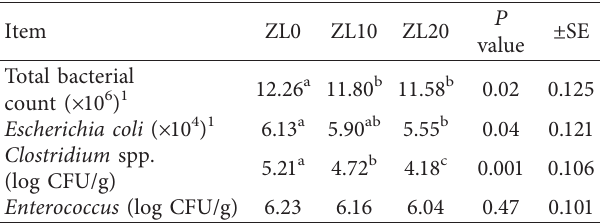
Table 3: Effects of dietary ZL supplementation on some ileal microbiota of growing rabbits.